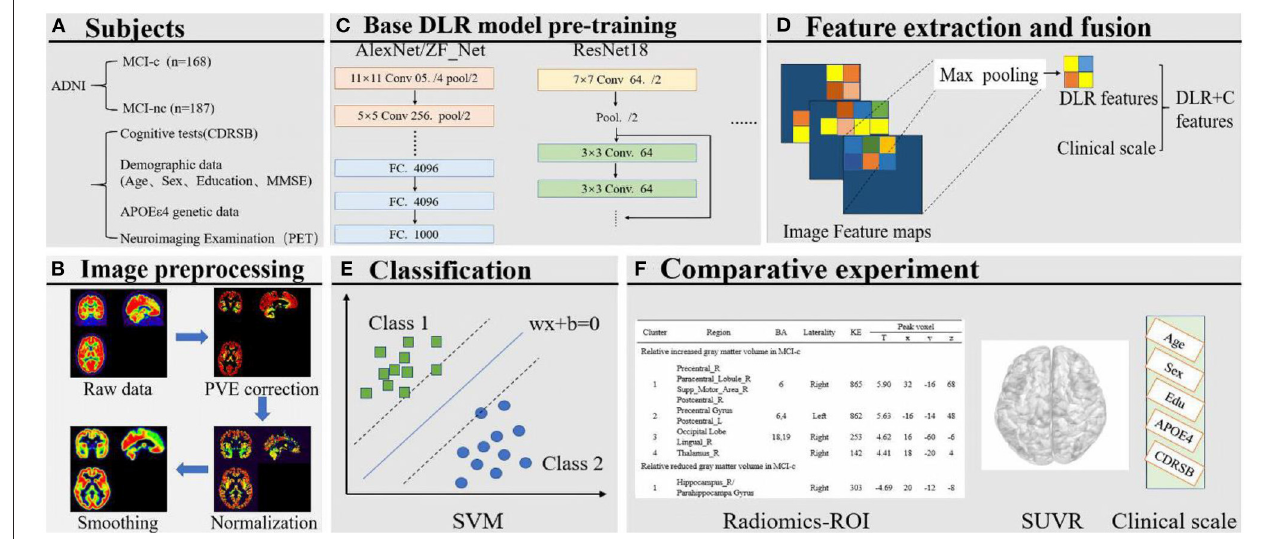
FIGURE 1 | (A) Collection of images and clinical scales. (B) Image preprocessing. (C) Base DL model pre-training. (D) Feature extraction and fusion. (E) Classification based on SVM. (F) Comparative